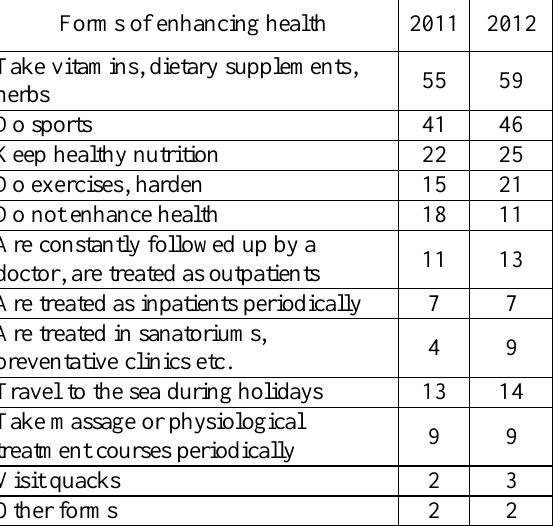
Table 2. Forms of enhancing personal students' health, 2011, 2012 (% from the number of respondents) Forms of enhancing health